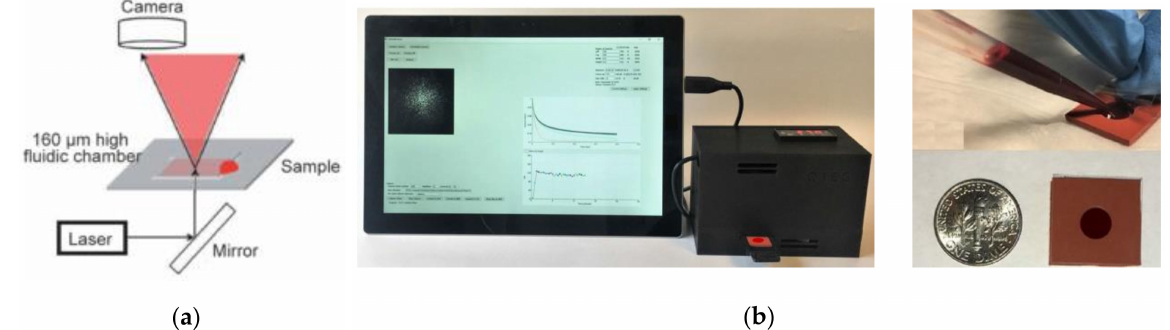
Figure 8. ( a ) Schematic of the optical setup, as engineered by Faivre et al. (Reprinted with permission from ref. [53]. Copyright 2011 SPIE Digital Library). ( b ) Photograph of the LSR based PT sensing module and test cartridge devised by Tripathi et al. (Reprinted with permission from ref.